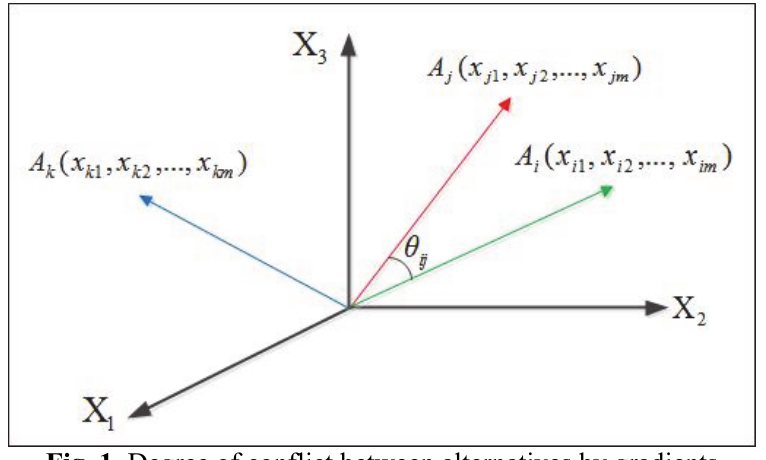
Fig. 1. Degree of conflict between alternatives by